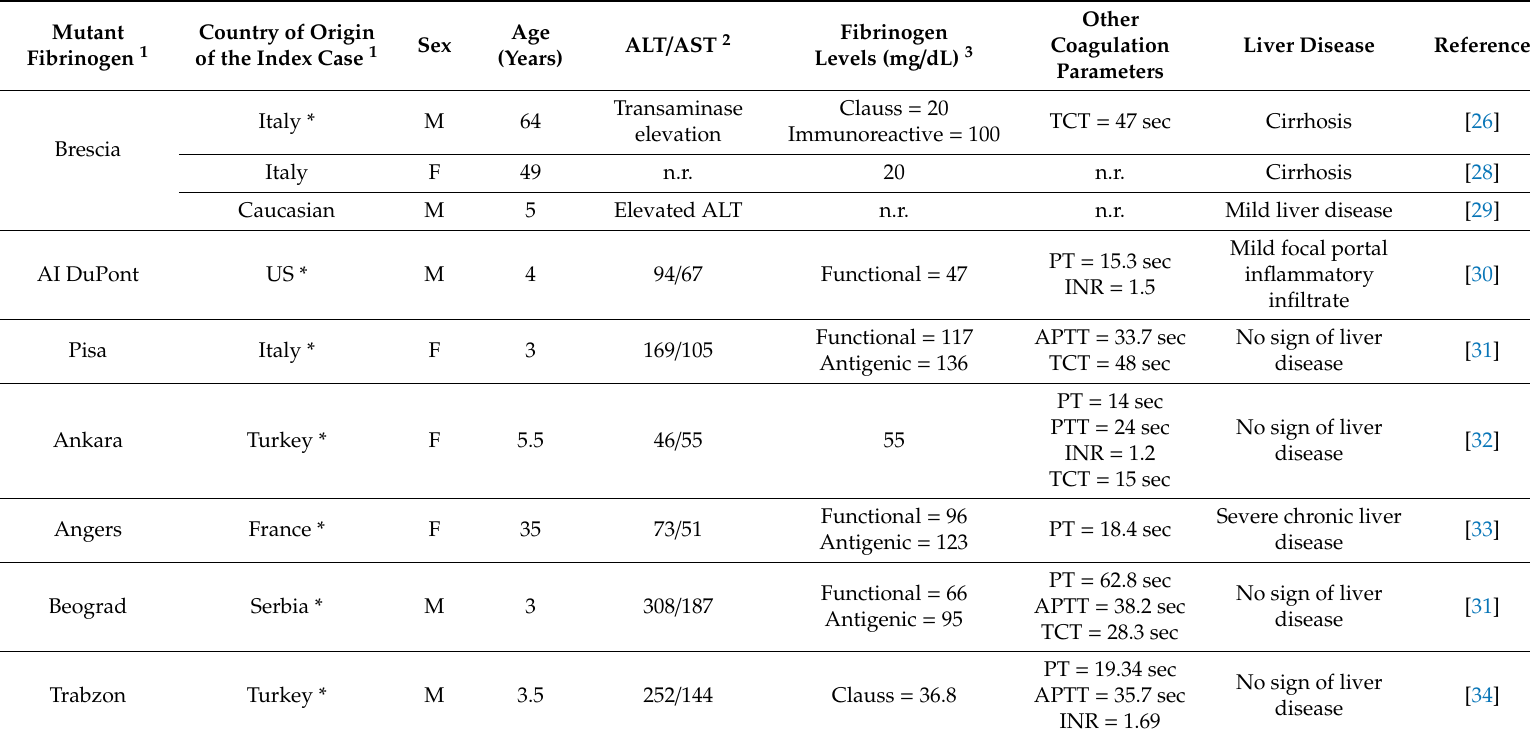
Table 1. Clinical characteristics of hypofibrinogenemia with hepatic storage (HHHS) probands with confirmed FGG